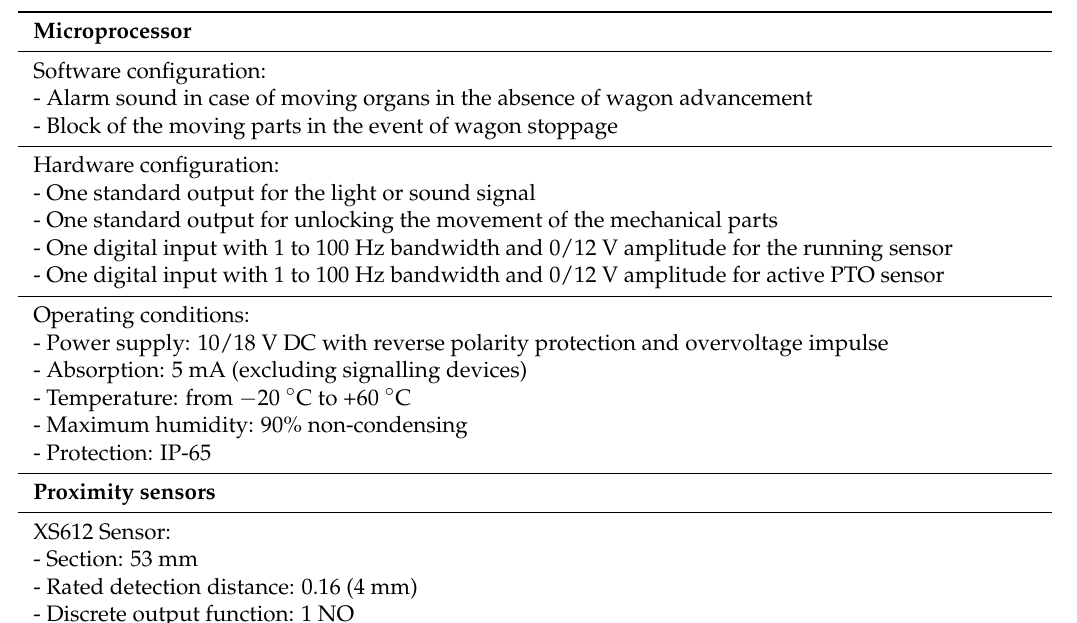
Table 4. Technical